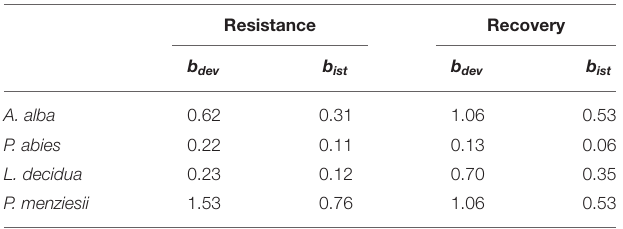
TABLE 4 | Average phenotypic stability of provenances throughout the observed drought events as revealed by Spearman’s rank correlations R s and Finlay and Wilkinson (1963) regression, where b dev is the mean deviation of all provenances from the species mean and b ist , the mean deviation of all instable provenances from the species